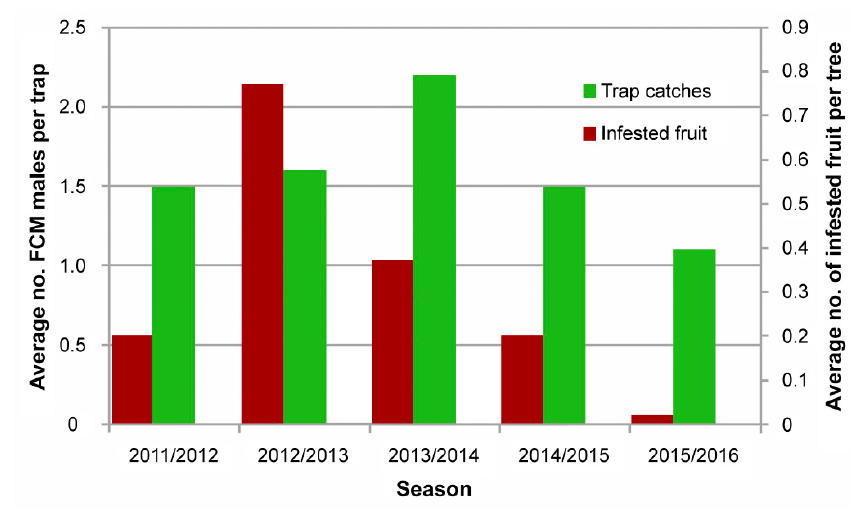
Figure 7. Wild false codling moth (FCM) trap catches and the average percentage of infested fruits per tree in the Sunday River Valley, Eastern Cape, South Africa, from 2011 to 2016 (reproduced with permission from Nevill Boersma, XSIT, Citrusdal, South Africa).